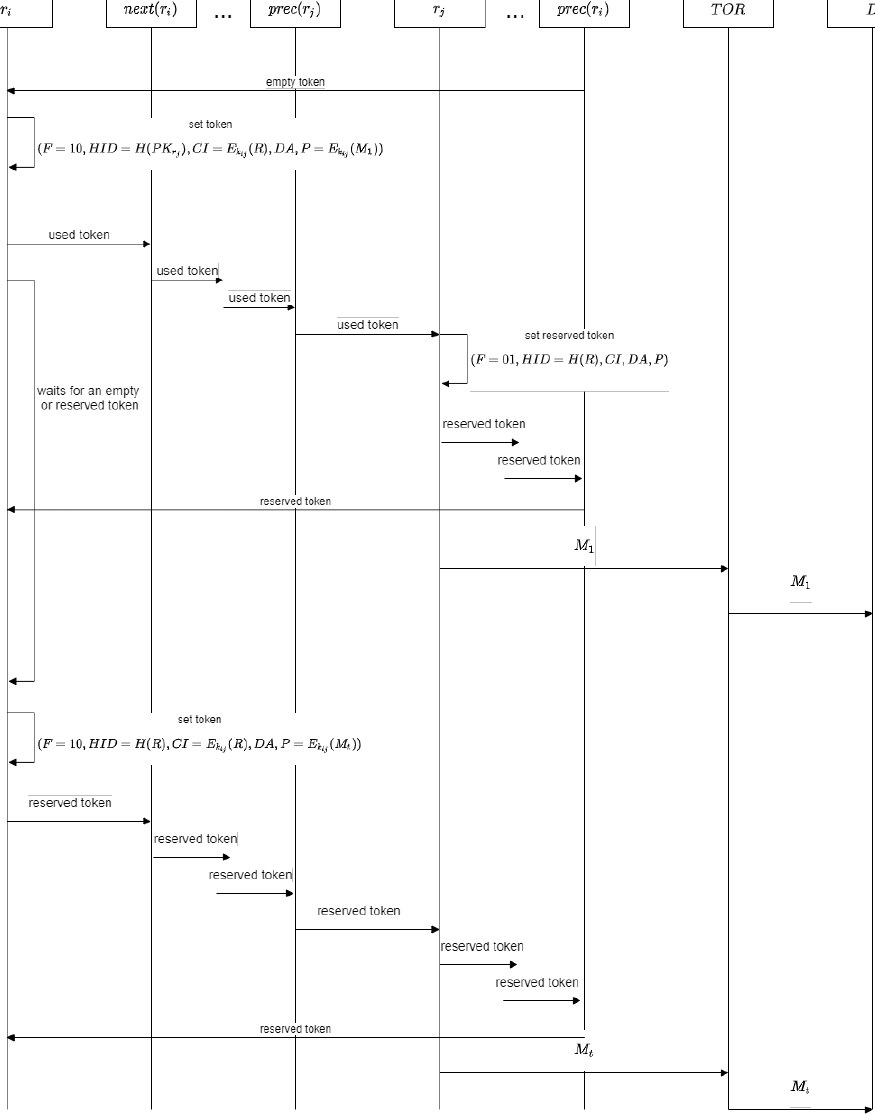
Figure 4. Transmission of the message M